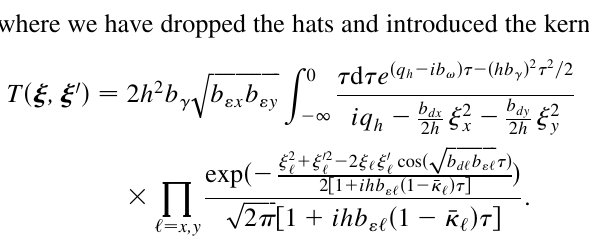
FIG. 1. (Color) Contour plot of dominant growth rate for fixed emittance and fixed beam